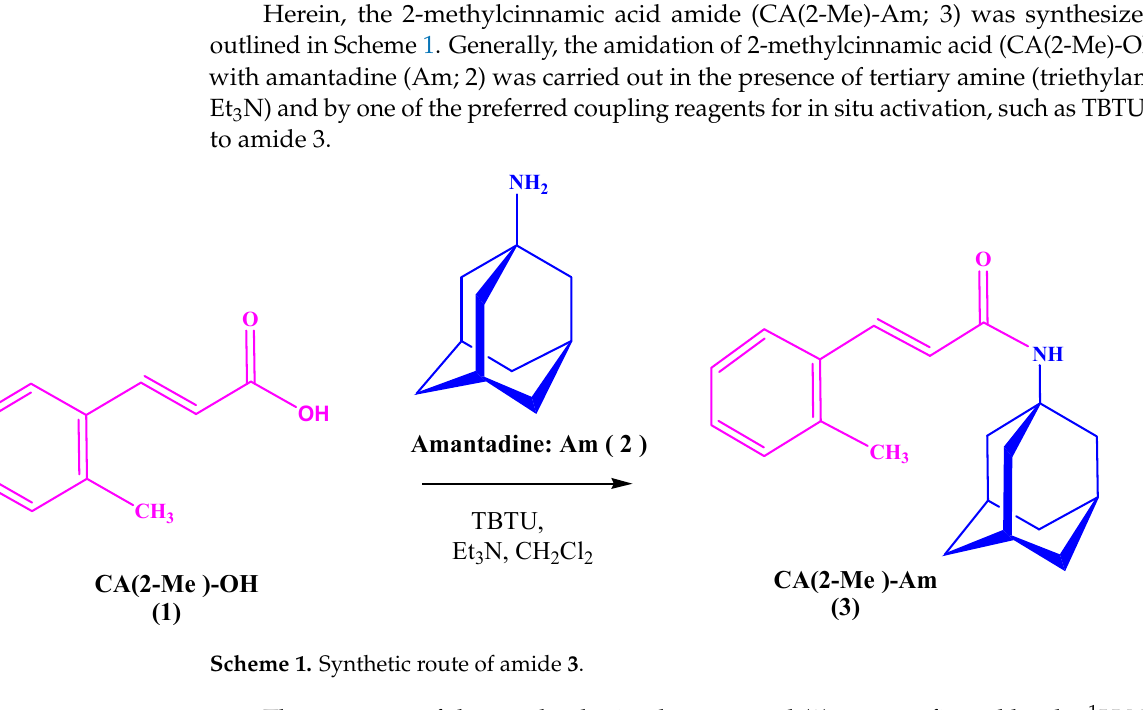
Table 1. The most important data collection and crystallographic refinement parameters for (E)=N-